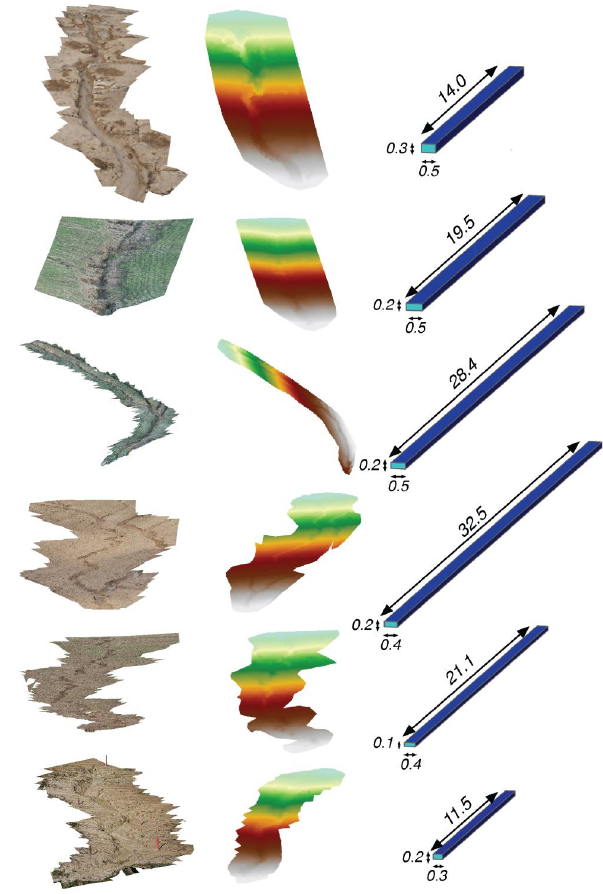
Figure 5. (a) Pictures of ephemeral gullies of different shapes (Navarre, Spain); (b) digital elevation model (DEM year n + 1 , see Fig. 4) of each gully; (c) equivalent prism of the gullies since there was no DEM available prior to the gully formation (DEM year n , see Fig. 4), the width was arbitrarily defined on the basis of abrupt changes at both gully banks (see Sect. 3)). It should be made clear that the geometry of the equivalent prisms could have changed (dra- matically) if we had also taken the corresponding DEM year n into account. (Please note that lengths are given in